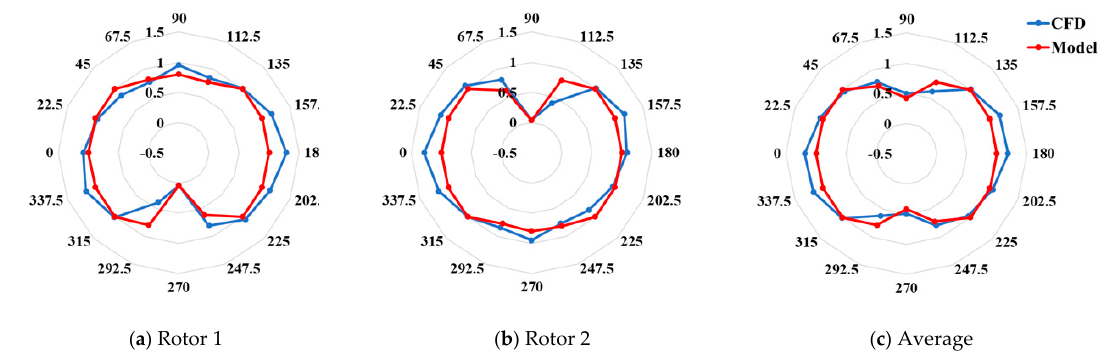
Figure 13. Distributions of normalized rotor powers in the CO-configuration in the case of gap = 0.5 D : ( a ) Rotor 1; ( b ) Rotor 2; ( c ) average.